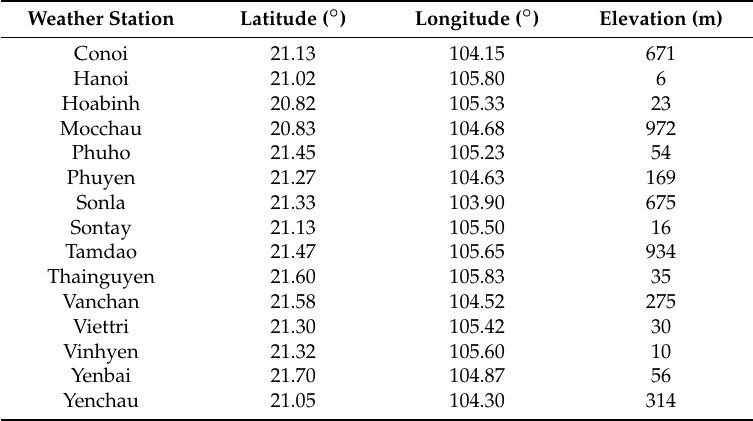
Table 2. Geographical description of weather stations used in this study.